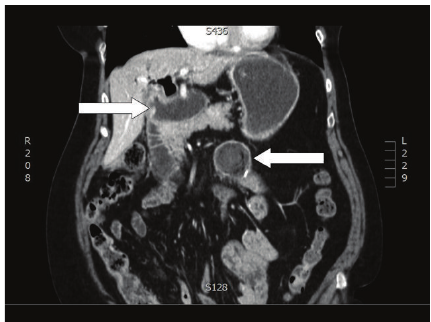
Figure 5: Duodenal fistula and bowel obstruction (personal obser-